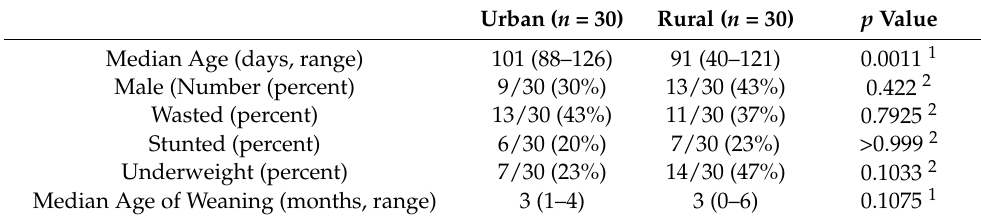
Table 1. Baseline Data for Children in Urban and Rural